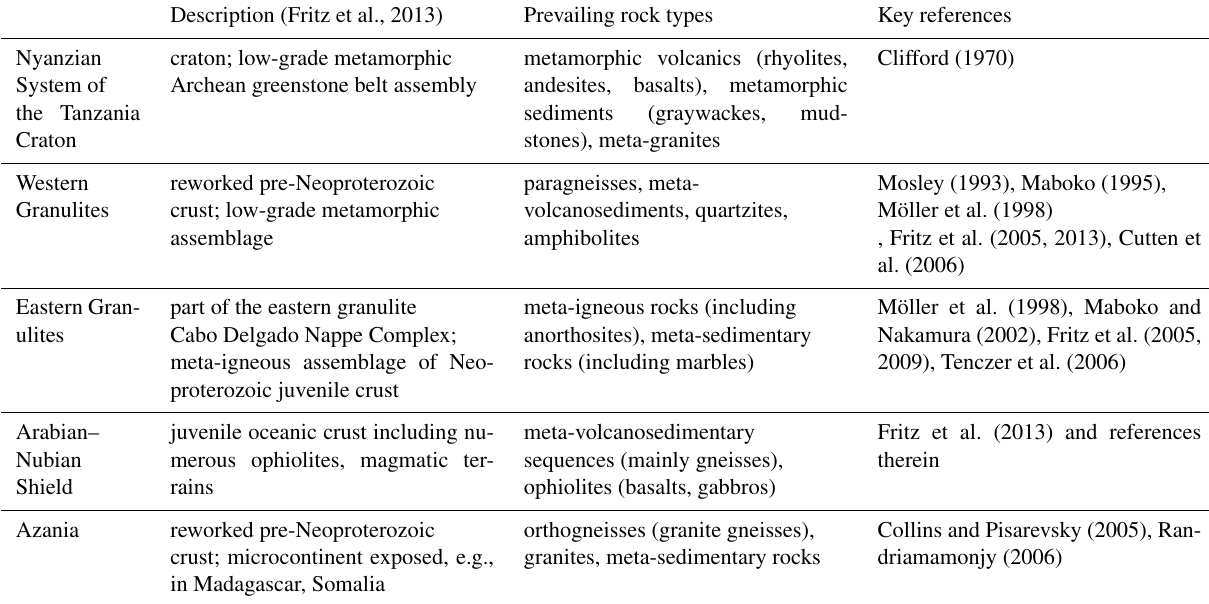
Table 3. Precambrian basement domains of the study area. Description (Fritz et al.,